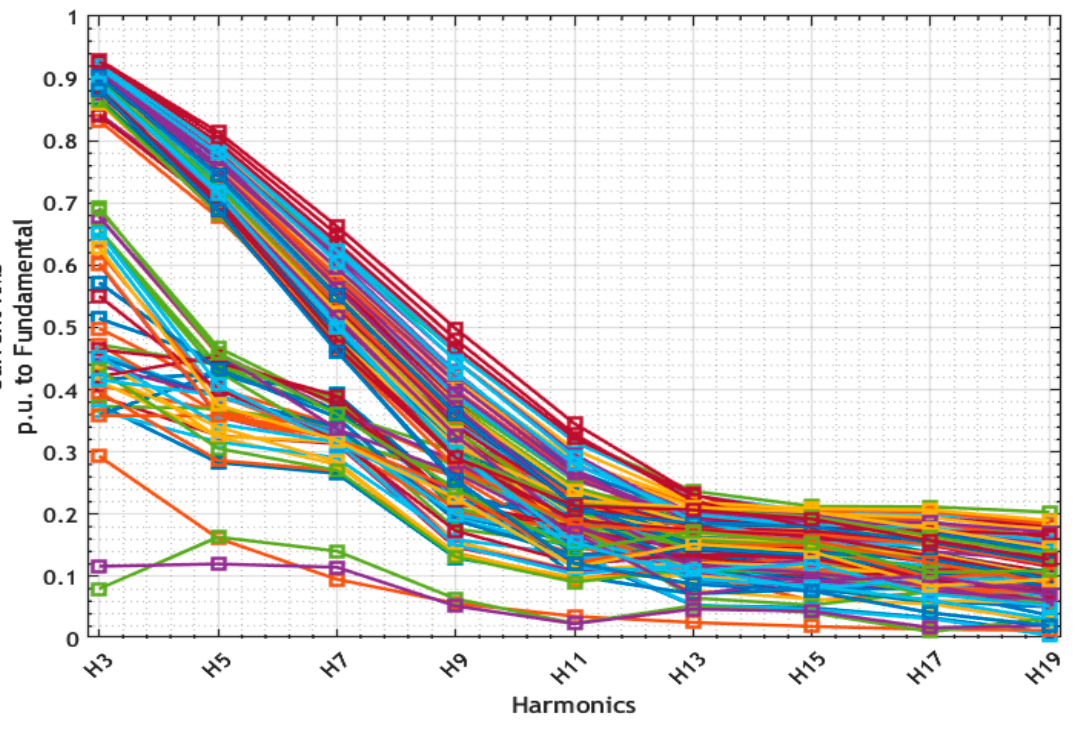
Figure 4. Measured harmonic currents’ RMS levels (with respect to RMS of fundamental harmonic current components) of 120 lamp combinations.